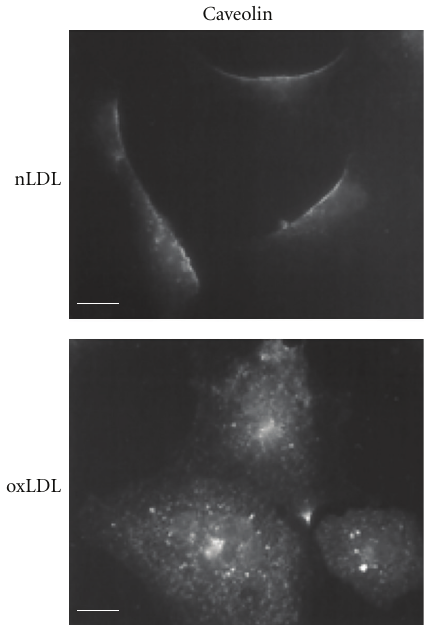
Figure 1: Oxidized LDL induces translocation of caveolin from the plasma membrane to intracellular compartments. Endothelial cells were treated with 10 μ g/mL of nonmodified LDL (nLDL) or oxLDL (15–20nmol/mg TBARS) in 100% lipoprotein-de ffi cient serum containing 20 mm HEPES (pH 7.4) for 1h at 37 ◦ C. Caveolin was visualized with a rhodamine isothiocyanate-goat antirabbit IgG. Adapted from